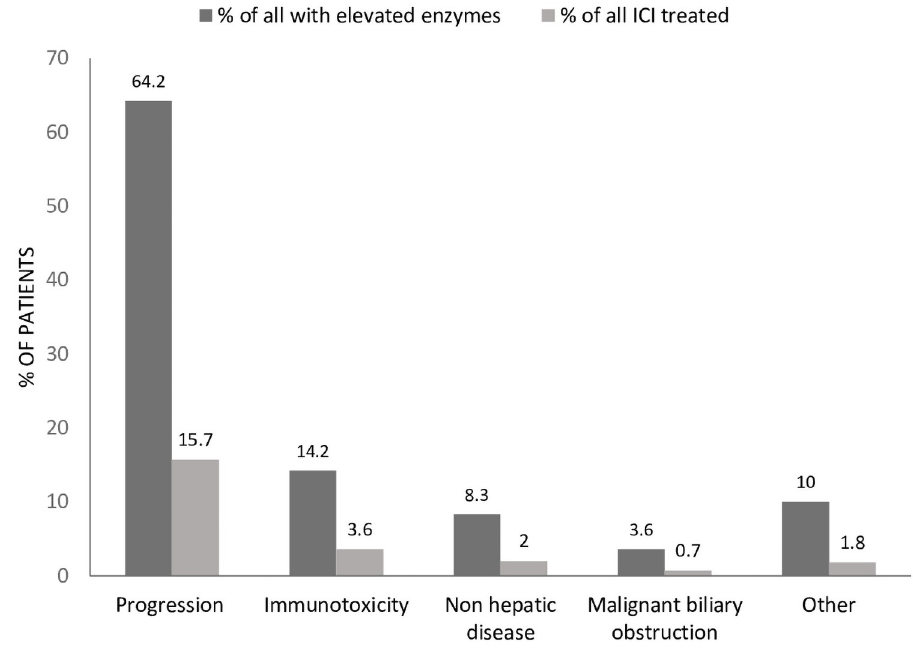
Fig 2. Final diagnoses of liver enzyme elevation after exposure to checkpoint inhibitor immunotherapy (ICI). Range and frequency of diagnoses that were made by the treating clinician, based on clinical assessment and results of investigations performed. Dark grey bars show patients with each diagnosis as a percentage of all patients with elevated lever enzymes after ICI exposure. Light grey bars show patients with each diagnosis as a percentage of all patients treated with